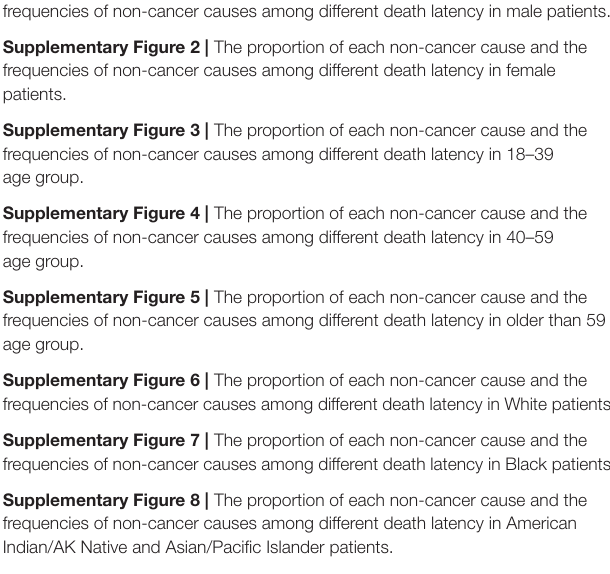
Supplementary Figure 1 | The proportion of each non-cancer cause and the frequencies of non-cancer causes among different death latency in male patients. Supplementary Figure 2 | The proportion of each non-cancer cause and the frequencies of non-cancer causes among different death latency in female patients. Supplementary Figure 3 | The proportion of each non-cancer cause and the frequencies of non-cancer causes among different death latency in 18–39 age group. Supplementary Figure 4 | The proportion of each non-cancer cause and the frequencies of non-cancer causes among different death latency in 40–59 age group. Supplementary Figure 5 | The proportion of each non-cancer cause and the frequencies of non-cancer causes among different death latency in older than 59 age group. Supplementary Figure 6 | The proportion of each non-cancer cause and the frequencies of non-cancer causes among different death latency in White patients. Supplementary Figure 7 | The proportion of each non-cancer cause and the frequencies of non-cancer causes among different death latency in Black patients. Supplementary Figure 8 | The proportion of each non-cancer cause and the frequencies of non-cancer causes among different death latency in American Indian/AK Native and Asian/Pacific Islander